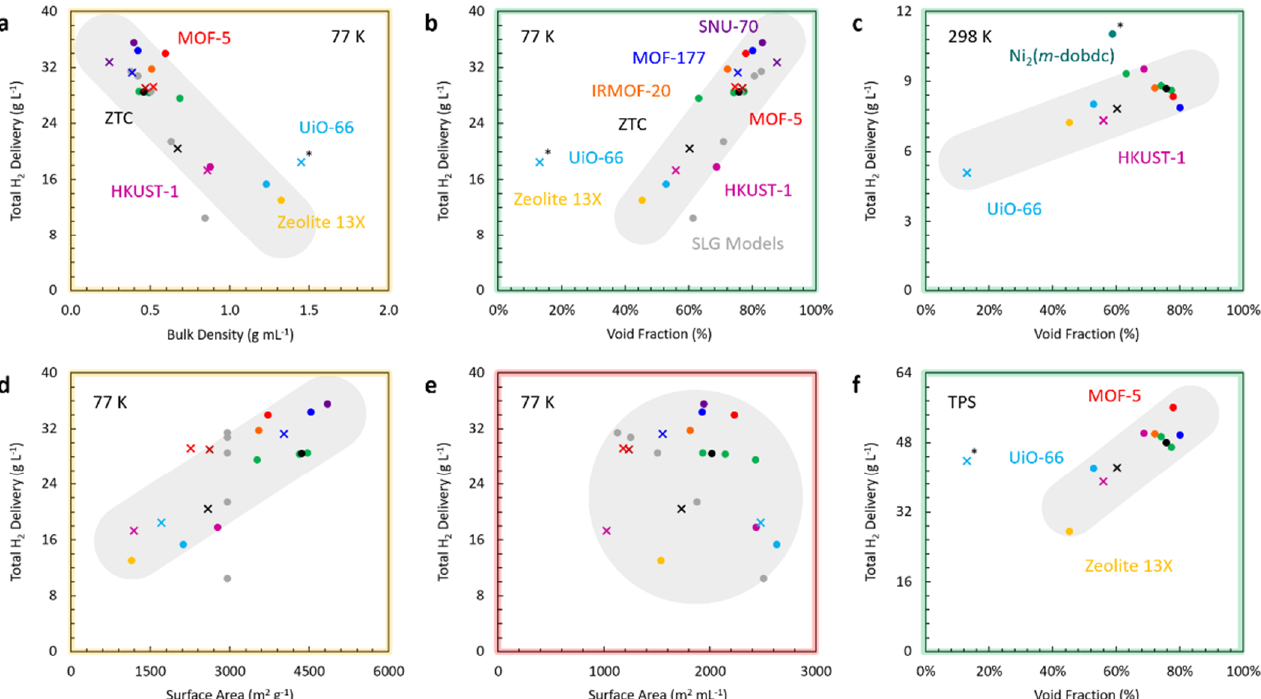
Figure 7. Total deliverable H 2 adsorption uptake on benchmark crystals and pellets/monoliths under ( a , b , d , e ) 5–100 bar PS at 77 K, ( c ) 5–100 bar PS at 298 K, or ( f ) 5–100 bar TPS between 298 and 77 K. Excess H 2 adsorption data were obtained from the same references as in Figures 5 and 6 (see Supplementary Materials). The crystalline assumption was employed for all crystals (●) and the skeletal assumption for all pellets (×). Outliers are indicated with an asterisk. The outline of each plot indicates the goodness of fit based on linear regression analysis.